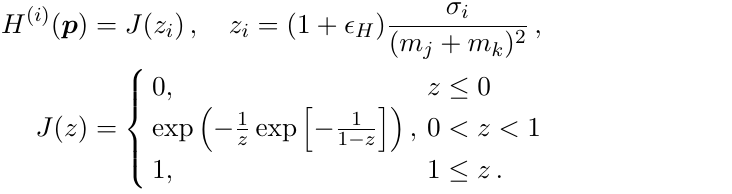
figure 1: for a degenerate pair, q ∗ ( i )2 which occurs at q ∗ ( i )2